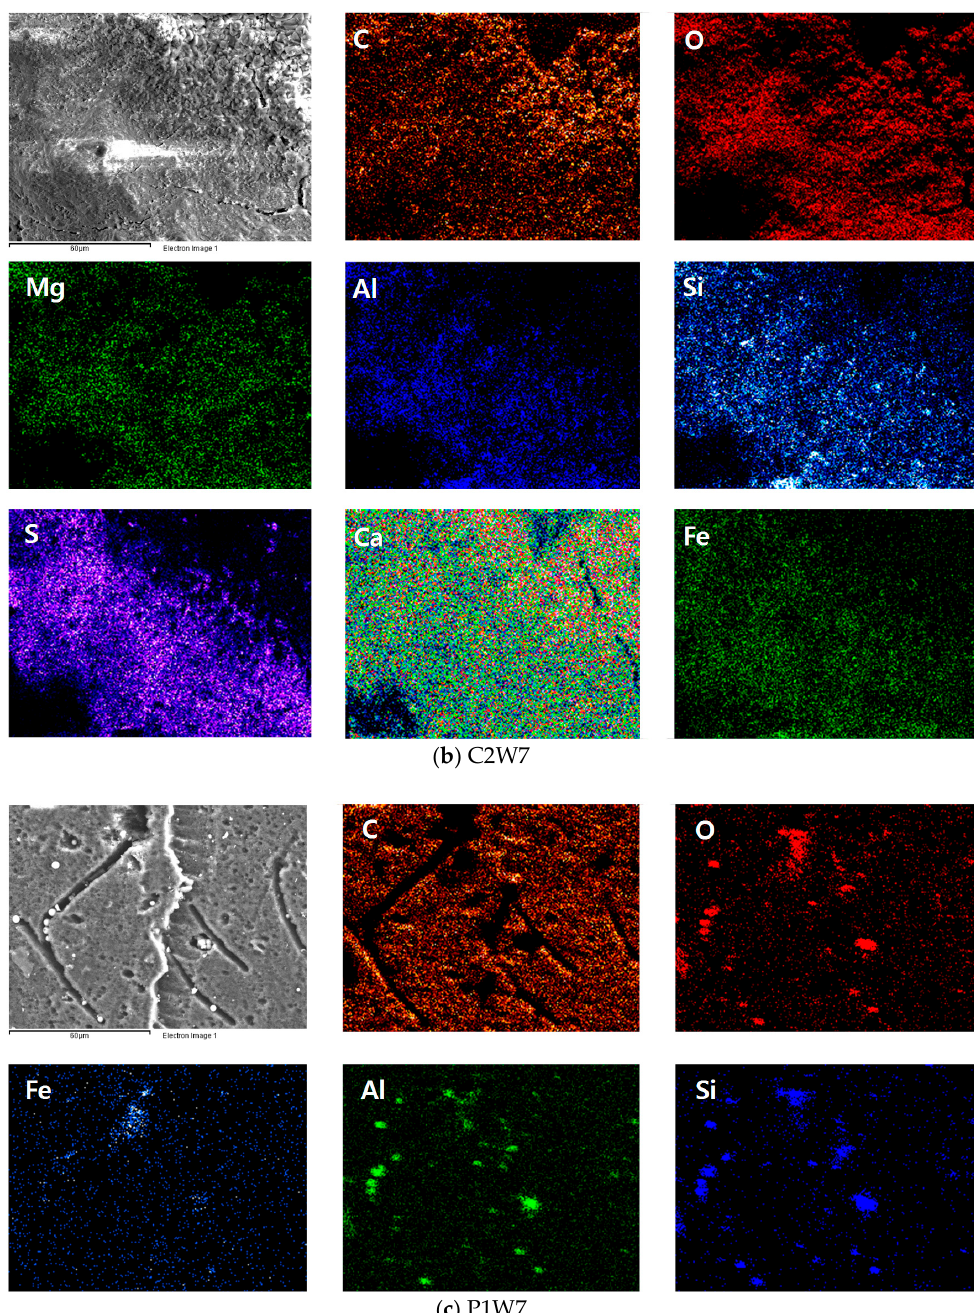
Figure 5. EDS elemental mapping images of ( a ) C1W7; ( b ) C2W7; and ( c ) P1W7.